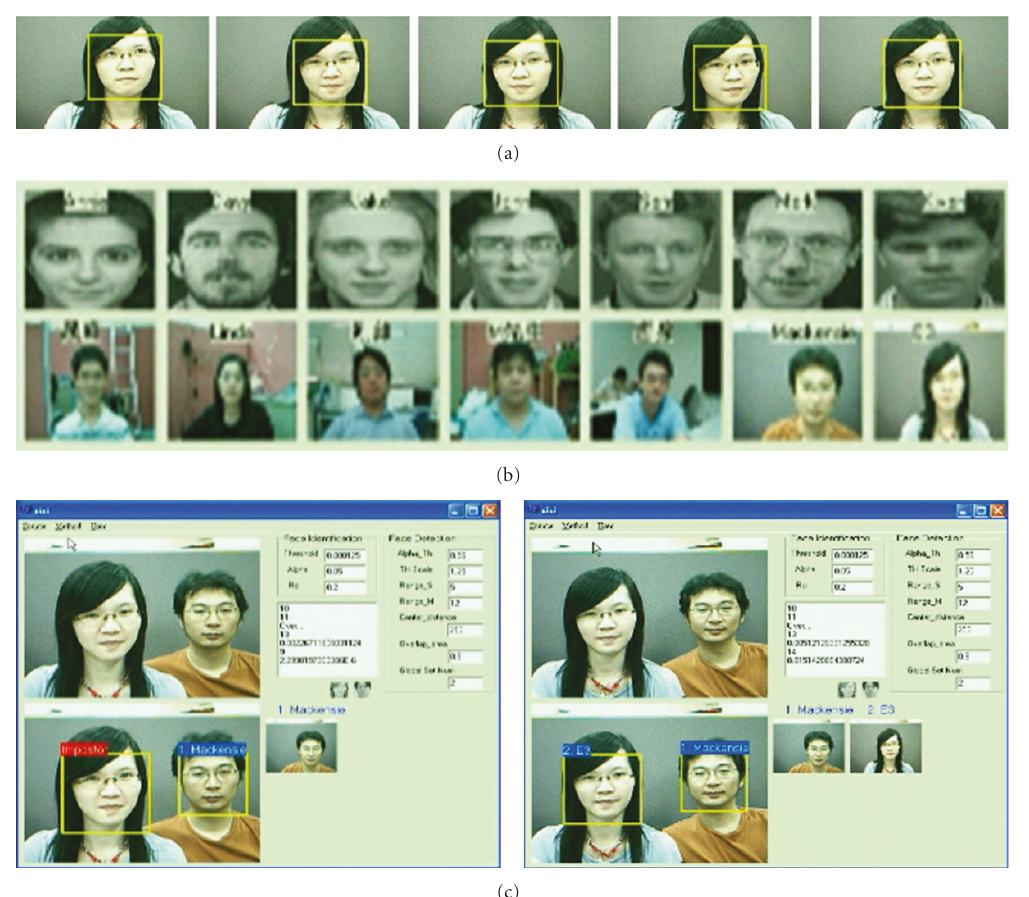
Figure 23: (a) A new client with di ff erent head orientations, (b) An overview of the updating database, (c) Face identifier before and after registering a new